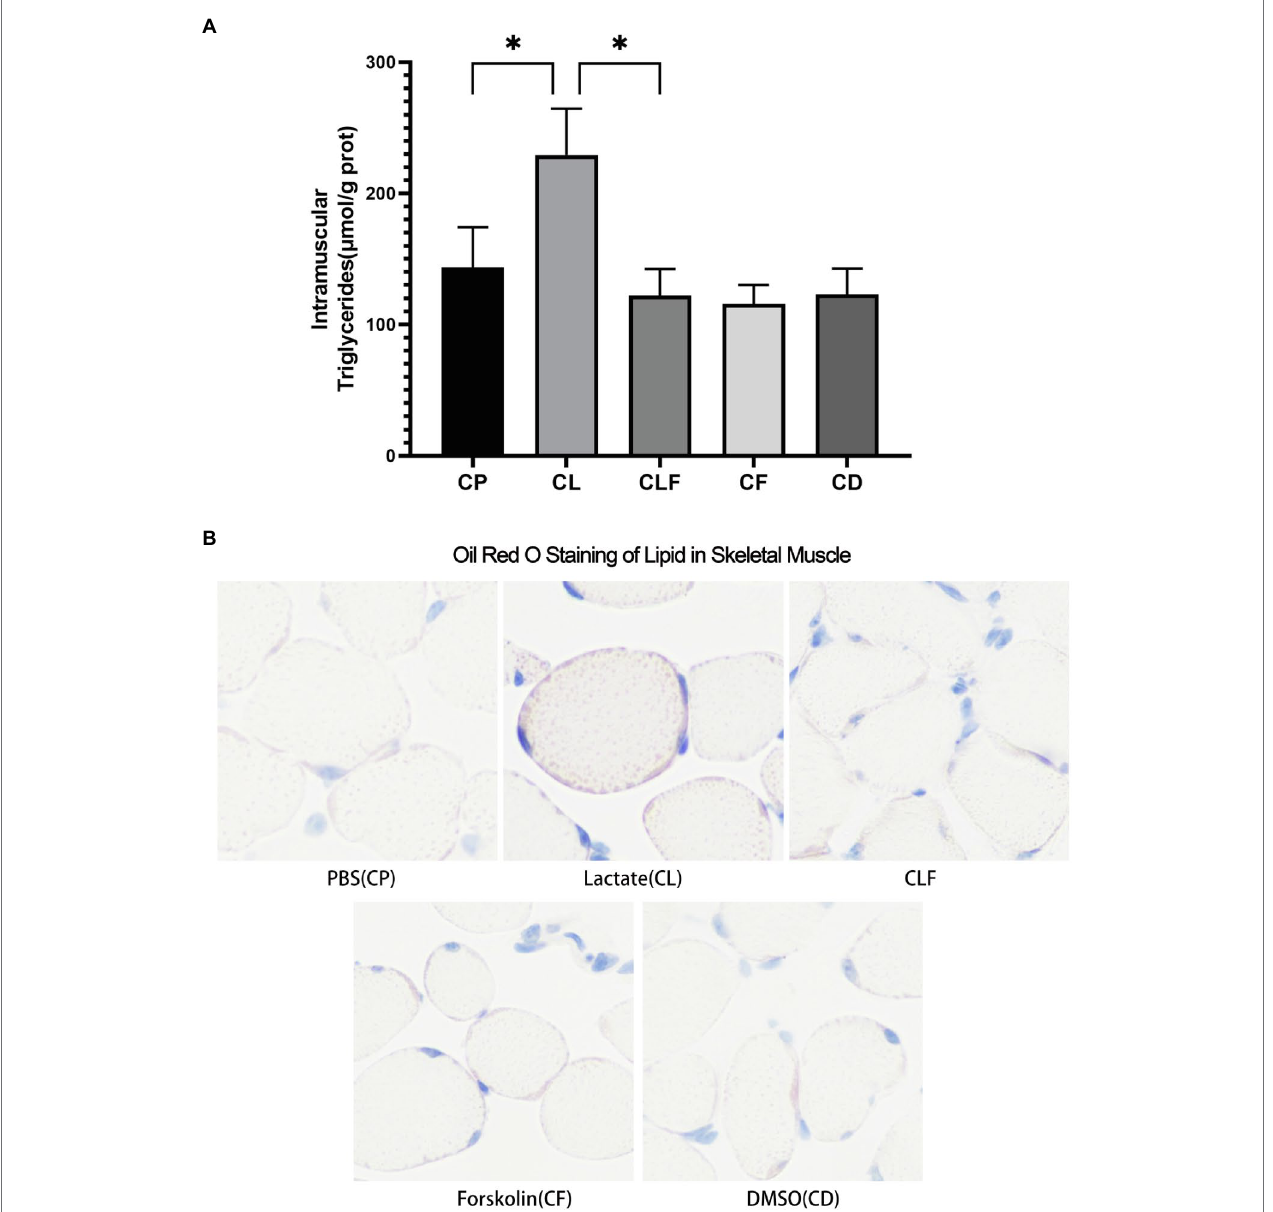
FIGURE 5 | Intramuscular triglyceride variation after chronic administration. (A) Intramuscular Triglycerides Abundance of Skeletal Muscle ( n = 6). (B) The Oil Red O Staining of gastrocnemius of mice ( n = 5). CP, chronic PBS treated group; CL, chronic lactate treated group; CF , chronic forskolin treated group; CD, chronic DMSO treated group; and CLF, chronic lactate and forskolin treated group. Other images can be found in the additional materials. Measurement data were expressed by mean ± SD, and significant differences among the groups were analyzed with one-way ANOVA. * p <